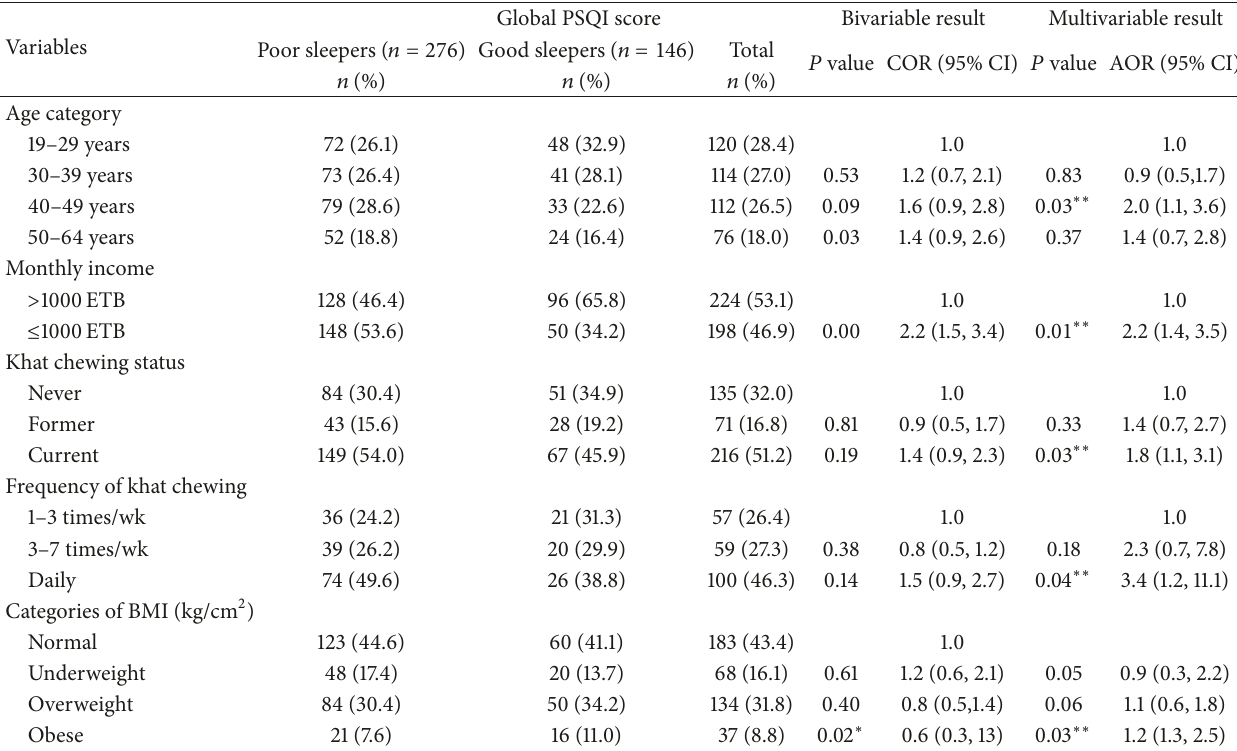
Table 6: Independent factors associated with poor sleep quality (sampled = 422) among adults in Jimma town, April 2016.